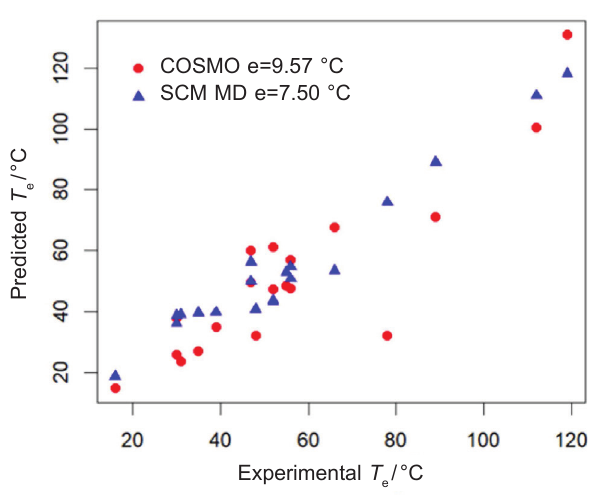
Fig. 6 – Comparison of experimental eutectic temperatures, T , with the predictions with COnductor like Screening MOdel e for Real Solvents (COSMO-RS), and structural causal model with molecular descriptors